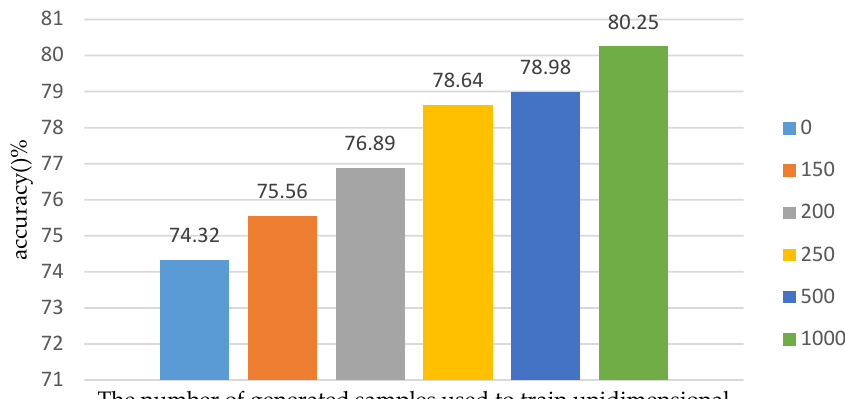
Figure 8. As the number of generated samples used to train unidimensional ACGAN changes, the average accuracy of unidimensional DenseNet changes.